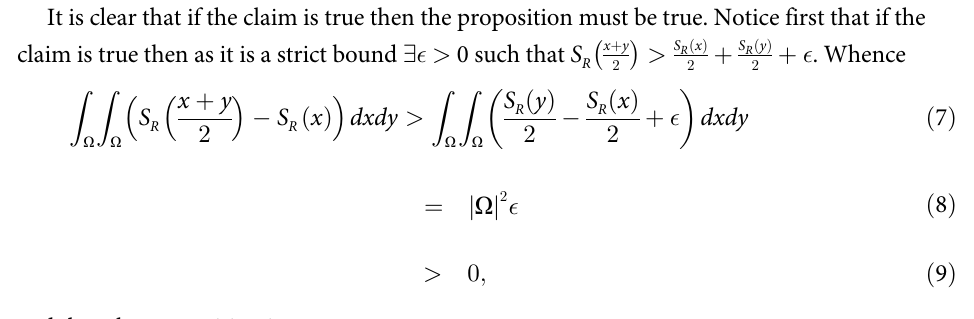
S1 Table. GEO and ArrayExpress accession numbers for the breast cancer and lung adeno- carcinoma data sets. Sample counts are provided for ER segregated and grade 2 samples in the case of breast cancer, and also for stage I samples in the case of lung adenocarcinoma. S2 Table. The genes utilised to construct the signalling entropy prognostic score in breast cancer, derived from the METABRIC discovery set. Genes are separated into those found to positively correlate with signalling entropy and those negatively correlated. S3 Table. The genes utilised to construct the signalling entropy prognostic score derived from the METABRIC validation set. Genes are separated into those found to positively correlate with signalling entropy and those negatively correlated, the genes which overlap with the discovery set derived set are highlighted in yellow. Also presented are genes which are prognostic independently of ER status and grade in both discovery and validation sets of METABRIC (middle table). Genes which are both prognostic and correlated with signalling entropy, independently of ER status and grade, in both discovery and validation sets of METABRIC are presented as the rightmost table. S4 Table. The genes utilised to construct the signalling entropy prognostic score in lung adenocarcinoma. Genes are separated into those found to positively correlate with signalling entropy and those negatively correlated. S5 Table. Genes utilised in the gene set enrichment analysis to identify gene sets associated with signalling entropy ’ s prognostic power in breast and lung cancer. In the case of breast cancer these are prognostic genes which correlate with signalling independently of ER status and grade and whose prognostic power is also independent of these variables, in both METAB- RIC data sets. In the case of lung cancer, these are prognostic genes which are correlated with signalling entropy independently of tumour stage and whose prognostic power is